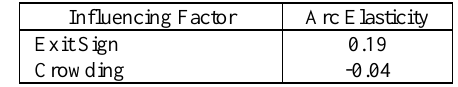
Table 7. Arc elasticity scenario 2